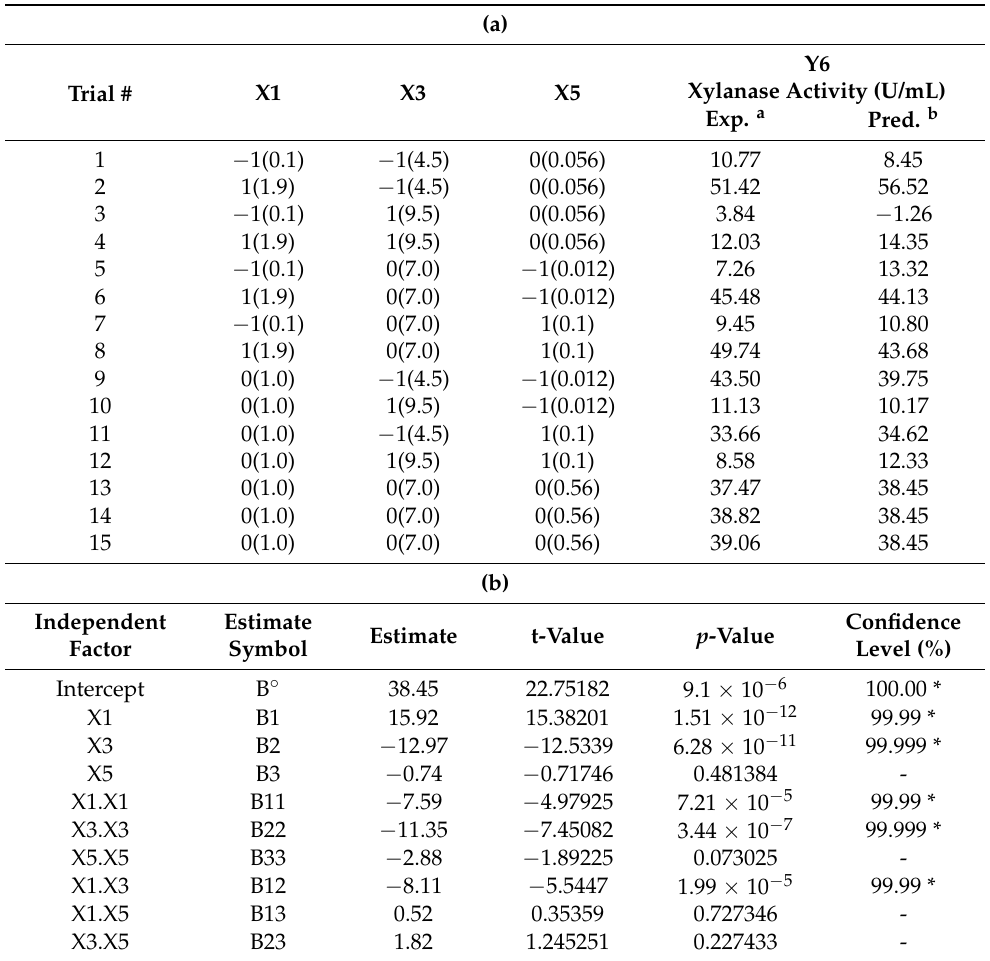
Table 2. ( a ) The levels of coded and real values of three independent factors in BBD for maximizing the xylanase production by P. chrysogenum strain A3 DSM105774. ( b ) Regression synopsis of BBD